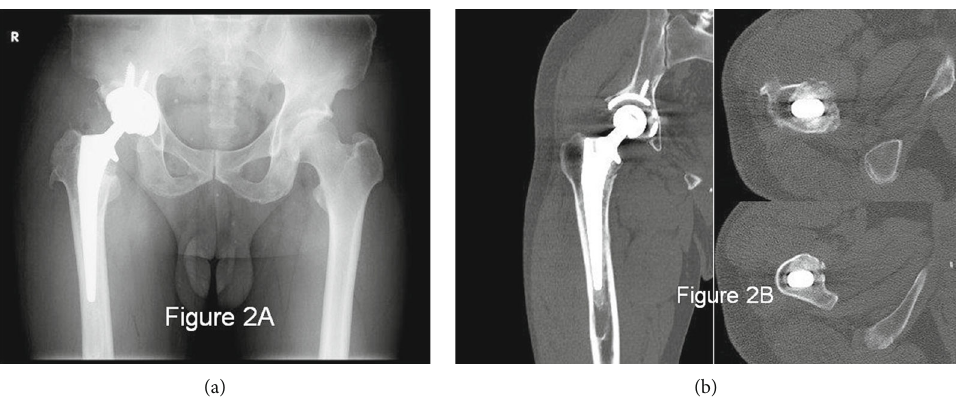
Figure 2: (a) Postoperative X-ray shows the strut allograft above the lesser trochanter and densely impacted bone graft in the thigh. (b) CT at 10 weeks shows regional welding between femoral prosthesis and femoral cortex especially on the lesser trochanter level. Beneath the lesser trochanter, a 4.5cm long longitudinal linear fracture line, which had already been in the process of healing was observed (not all images shown).